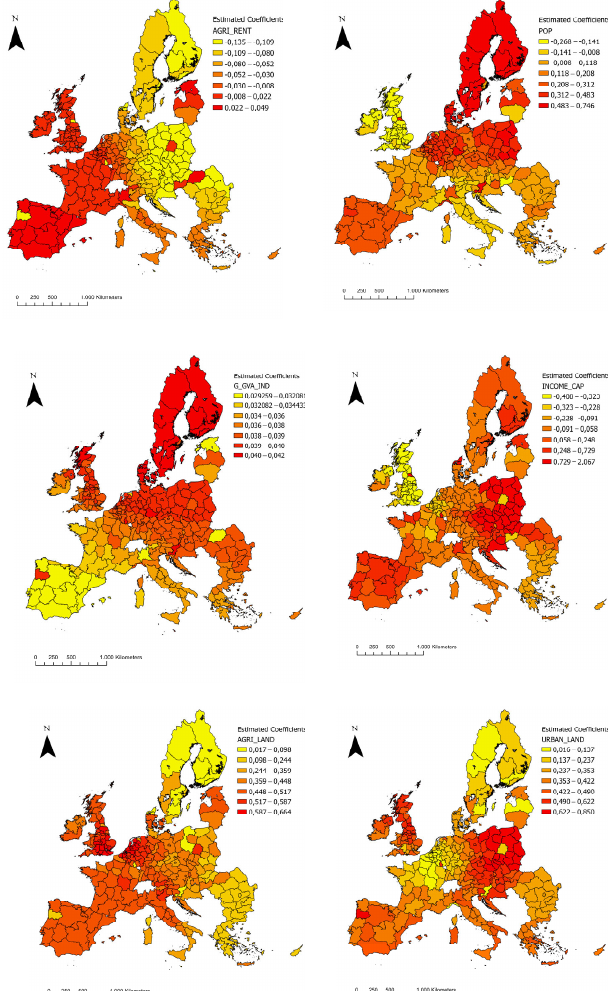
Figure 7. Spatial distribution of local coefficients in MGWR model. Source: authors’ own work.